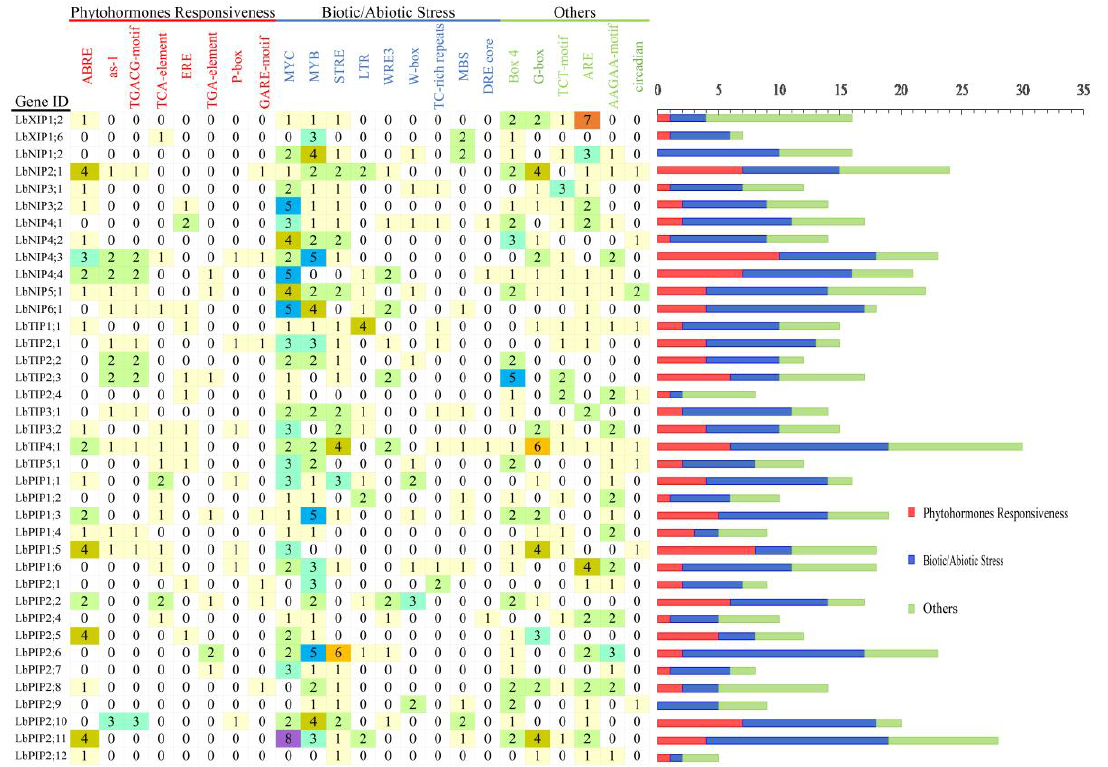
Figure 5. The cis-acting elements on the putative promoters of the LbAQP genes. The identified cis- acting elements were mainly divided into three major categories: phytohormone responsiveness, biotic/abiotic stress, and